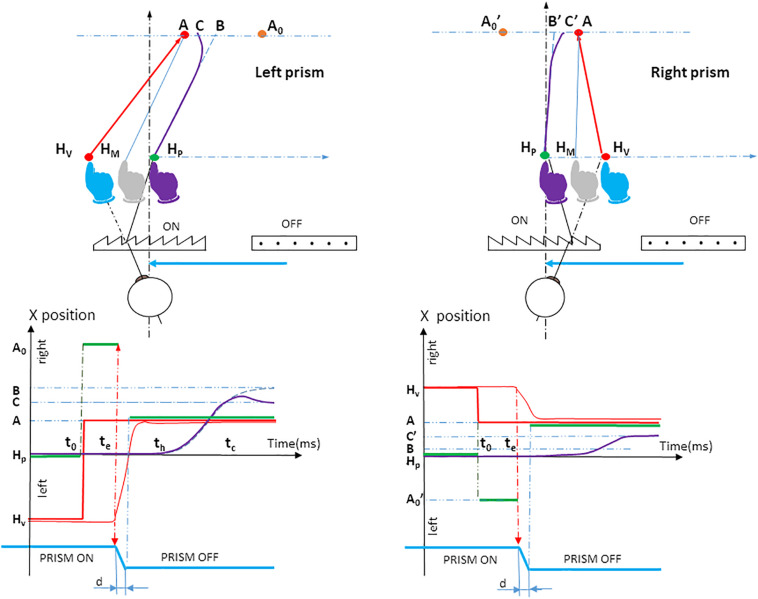
Prism experiment procedure. The upper panel shows the spatiotemporal arrangement of the orthogonal projection of the hand movement onto the pointing plane P3, for left and right prism displacements. The participant initially positioned his or her fingertip at fixation target HP. The physical location of the fingertip is indicated in purple. Both the seen HP fixation target (red LED) and the seen fingertip (blue) were located on the virtual image HV due to the visual prism displacement. When the hand (purple) had been maintained on the red fixation target HP for 1 s, the fixation target was cut off; simultaneously a red peripheral target was turned on at location A0. Seen through the prism, the target A0 appears at A. The eye saccade was performed along vector HvA. At saccade onset, there was a switch from prism to null prism viewing, which occurred simultaneously with a jump of the peripheral target from A0 to A to compensate for the prism removal. During unperturbed trials (null prism), the initial target stimulus was presented at location A. The vision of the hand was not distorted. Initially the hand moves toward a point B (blue dotted line); this is followed by a correction (bold purple line) that deviates the movement to point C. BA represents the actual planning error, taking into account the visual-proprioceptive weighting of the perceived hand position: the gray hand at HM can be considered as the initial weighted average of prism-distorted vision (blue hand) and unaltered proprioception of the hand (purple hand) seen through the prisms before movement onset. HMA is a theoretical parallel vector to HPB. Dotted blue line: planned hand pointing; Bold purple line: actual hand pointing; HP: the physical fixation target; HV: the seen fixation target; Purple hand: the physical position of the hand before prism onset, and the felt perception of the hand based on proprioception; Blue hand: prism-distorted vision of the hand before movement onset; Gray hand at HM: initial weighted average of vision and proprioception of the hand seen through the prisms before movement onset; A0, initial peripheral target seen at A through the prisms; A, peripheral target after prism removal. Note that the participant always perceives the peripheral target in A; B, the final point of the initially planned movement; C, the final point of the movement after correcting for the deviation. The lower panel shows the timing of stimuli and responses. Horizontal green segments indicate different horizontal, physical target locations on the pointing table: Hp (seen at Hv until time t0, which indicates the time at which Hp is cut off and A0 is lit); A0 from t0 to te, which indicates saccade onset (seen in A) A from te+d until trial end (seen naturally), d being the duration of prism switching. Thin red, vertical dotted arrows represent the time of prism removal, when simultaneously the target was shifted in order to maintain the view of the peripheral target A stationary. As a result, the participant’s view of the target was a simple jump from Hv to A (bold red step). At time th, about 100 ms after saccade onset, the hand was initially planned to move toward a point B (blue dotted line), followed by a correction at time tc (bold purple line) that deviated the movement to point C. The (thin blue vertical) arrow tc is the time of divergence – from the initially planned movement to the corrective movement. Green segments, lateral positions of the physical target; Bold red segments, lateral positions of the seen target; Dotted blue line, (lateral direction of) planned hand pointing; Bold purple line, (lateral direction of) hand pointing; Thin red line, lateral direction of eye saccade; t0, appearance of the peripheral target A; te, saccade onset; th, hand movement onset; tc, correction latency; HP, the physical fixation target; HV, the seen fixation target; A0, the initial peripheral target seen at A through the prisms; A, the peripheral target after prism removal. Note that the participant always perceives the peripheral target in A; B, the final point of the initially planned movement; C, the final point of the movement after correcting for the deviation.